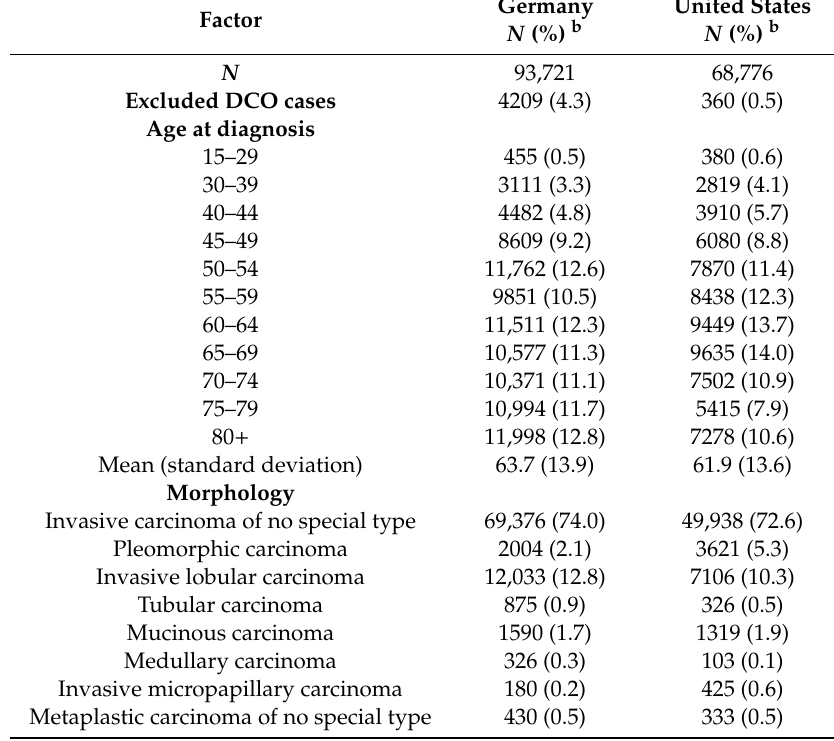
Table 1. Patient and tumor characteristics of patients with a first invasive breast cancer diagnosed in Germany and the United States in